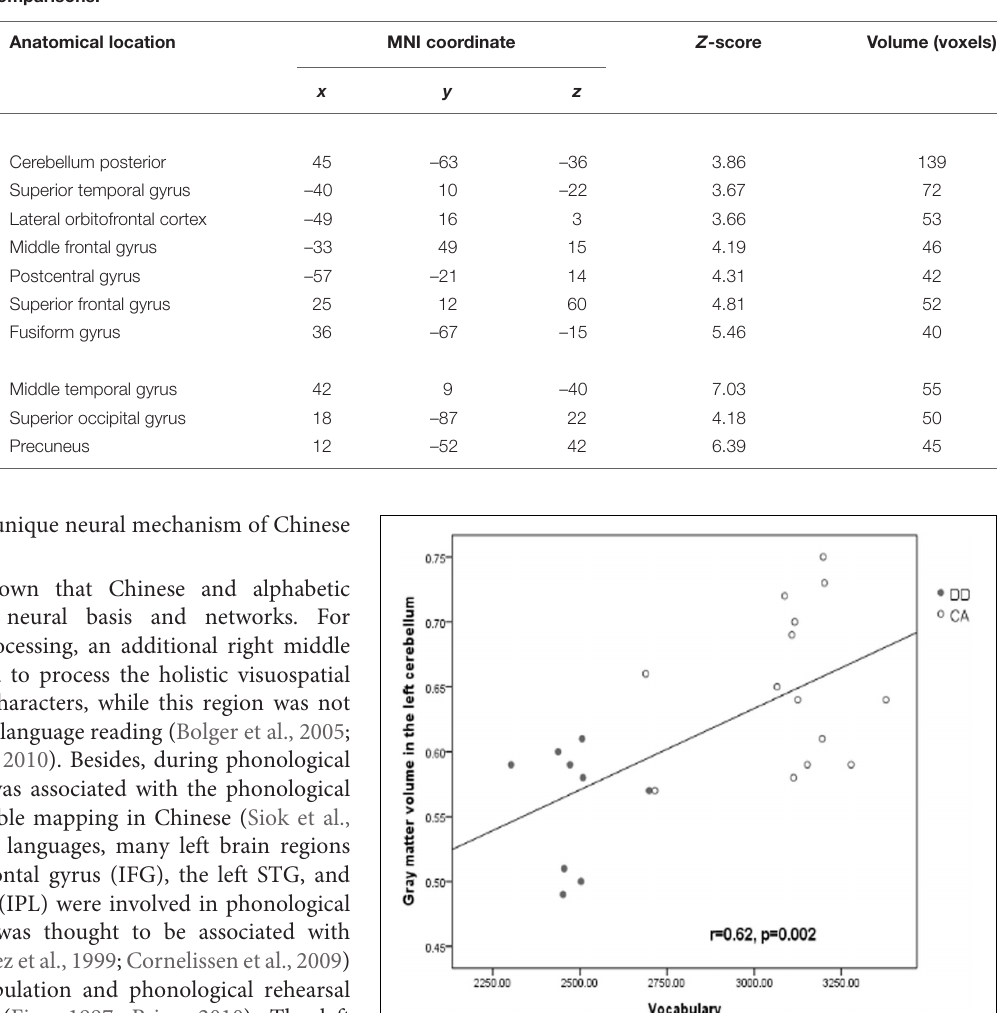
TABLE 2 | Gray matter volume comparisons.